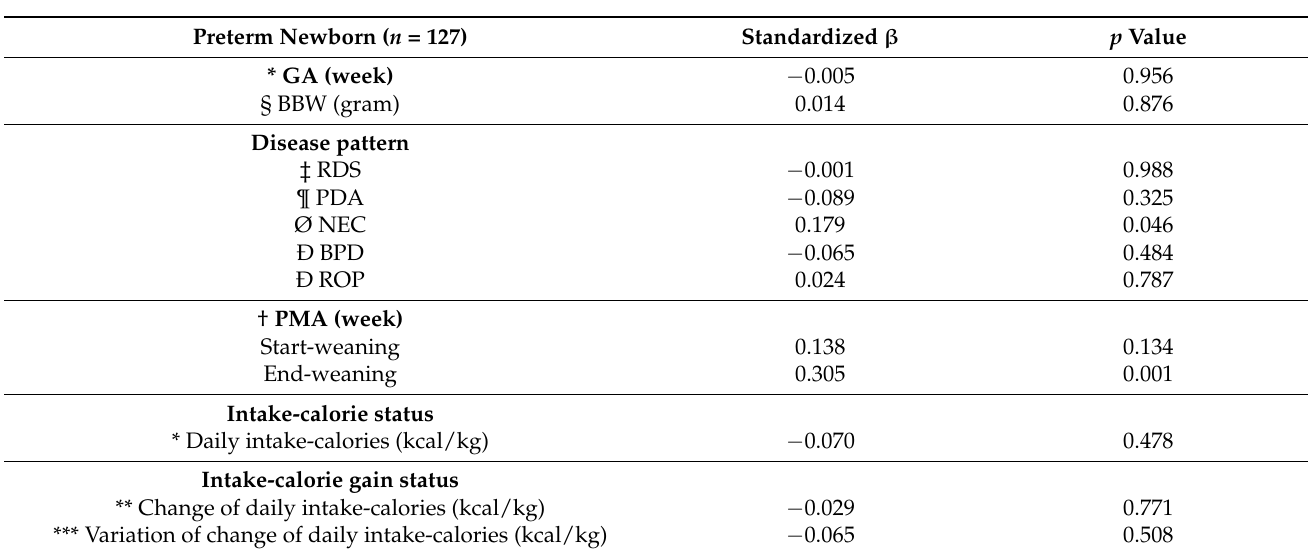
Table 4. Correlation of GA, BBW, and clinical characteristics with the end-weaning body weights of preterm newborns enrolled in the NICU of Kaohsiung Medical University Hospital by means of univariate linear